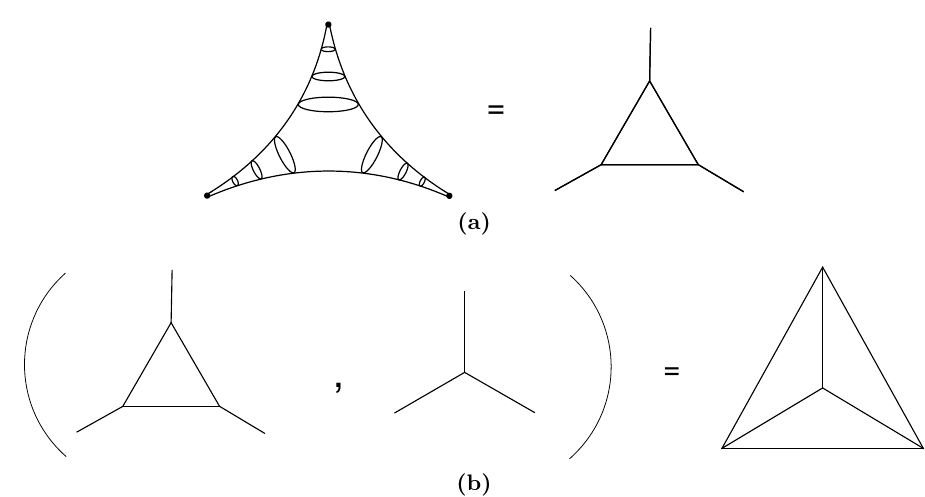
Figure 2. (a) The sum of the planar Feynman diagram contribution to the SYK three-point function of bilinears is given by three conformal three-point functions glued together. The (cid:12)gure on the right is not a Feynman diagram; each vertex is a three-point function. (b) The inner product with a bare three-point function of shadow operators extracts the structure constant, and is equal to a 6 j